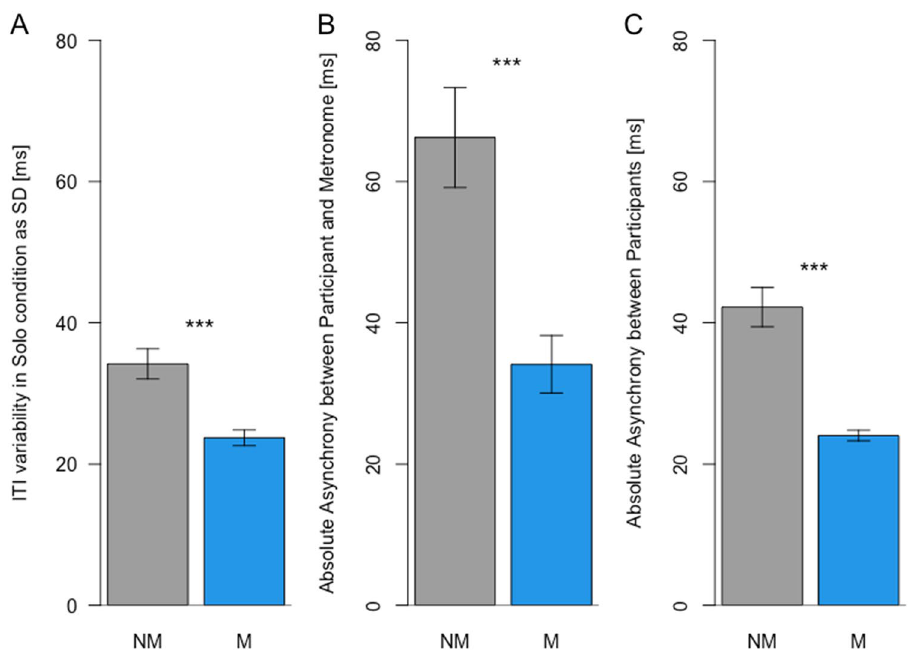
Figure 4. The difference between Non-Musicians (NM) and Musicians (M) for three different measures of timing performance. ( A ) The difference in ITI variability, which was computed from all trials in the Solo condition. ( B ) The difference in absolute asynchrony which was calculated on data from the Time Bin 0 of all trials, as Time Bin 0 was the same, i.e., participants heard and synchronized to a metronome, in all conditions. ( C ) Absolute asynchrony as computed on all trials from the Joint condition, in which participants could hear each